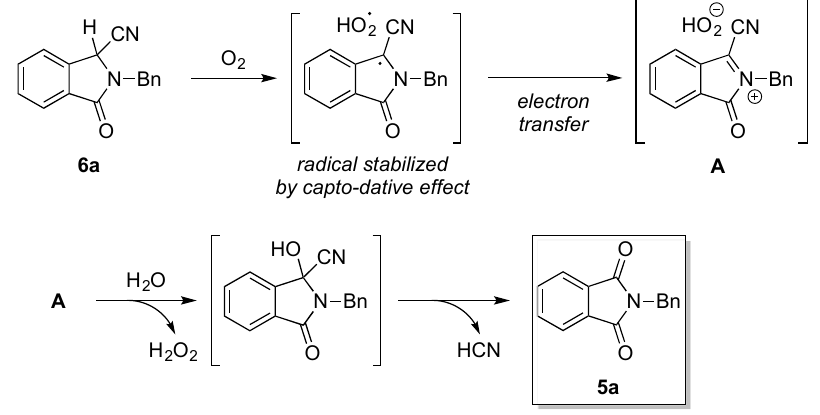
Scheme 2. Possible reaction mechanism for the formation of 5a in the ball